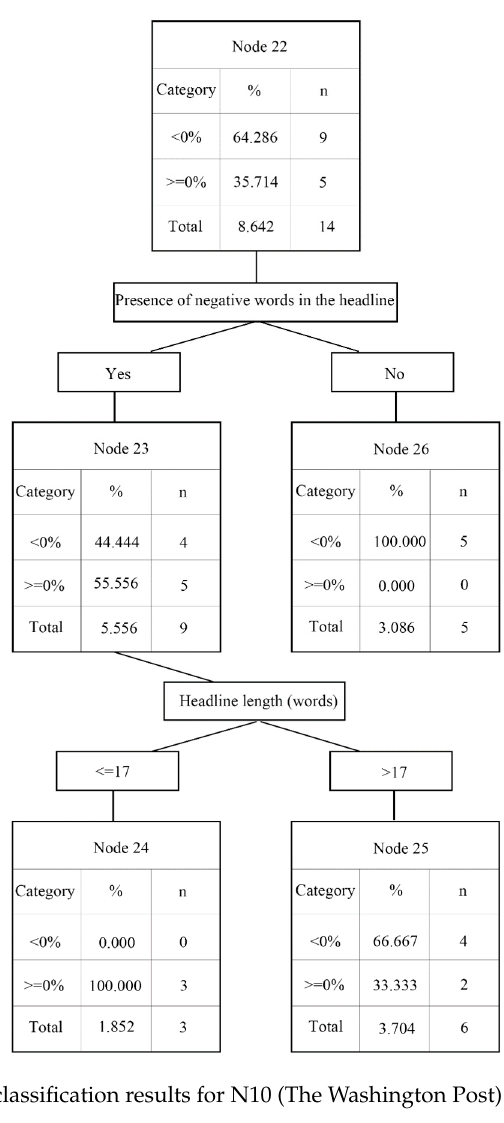
Big Data Cogn. Comput. 2019 , 3 FOR PEER REVIEW Figure 11. The classification results for N10 (The Washington Post) at Nodes 22–26.